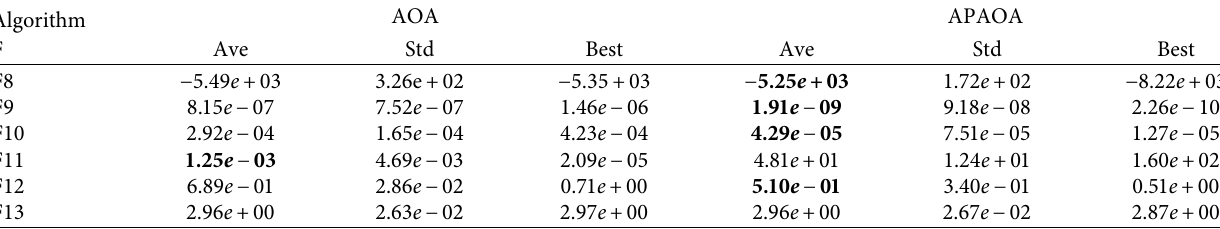
Table 5: Multimodal function test on 30D.